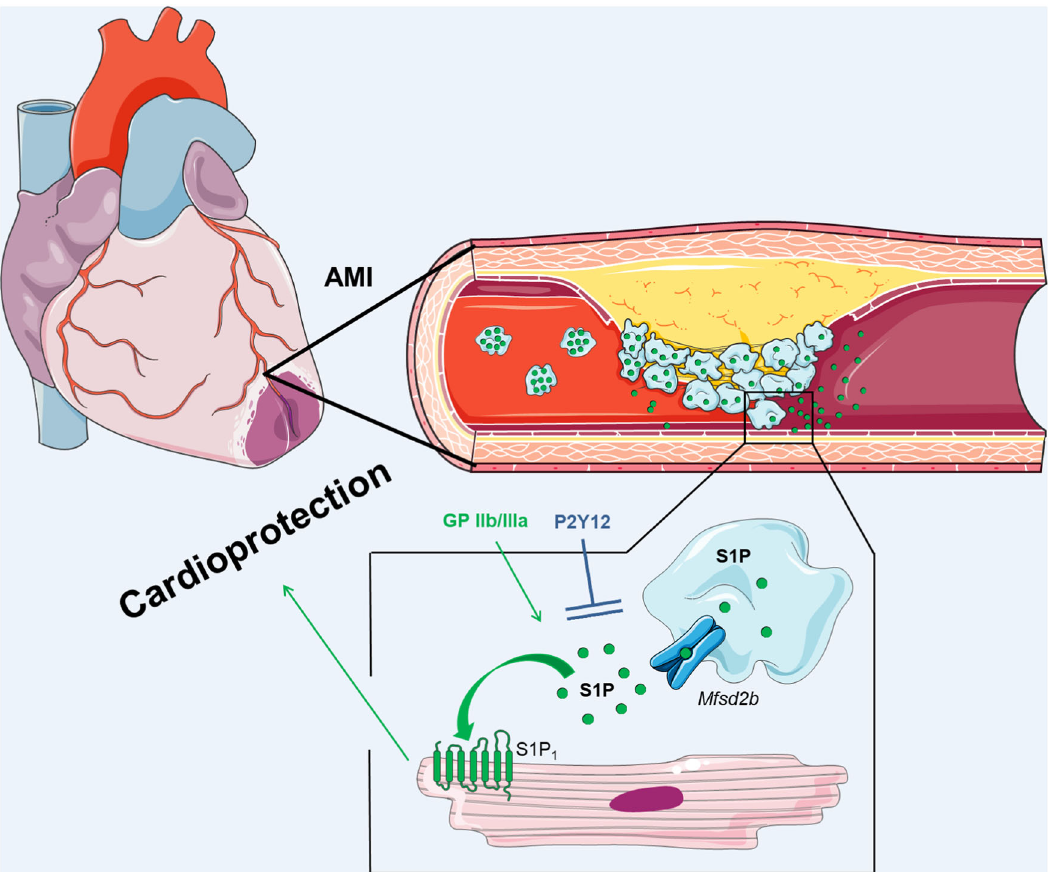
Fig. 4 | Main fi ndings of this study. Activated platelets release S1P during acute myocardial infarction (AMI) through the S1P exporter Mfsd2b ; platelet-derived S1P during AMI is cardioprotective by engaging the cardiomyocyte S1P 1 ; platelet S1P- mediated cardioprotection is preserved with GPIIb/IIIa antagonists, but not